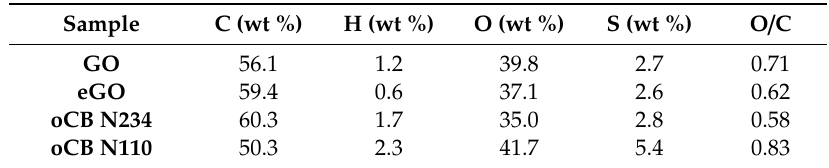
Table 1. Elemental analysis of the obtained graphite oxide (GO), exfoliated graphene oxide (eGO) and of two oxidized carbon black (oCB)